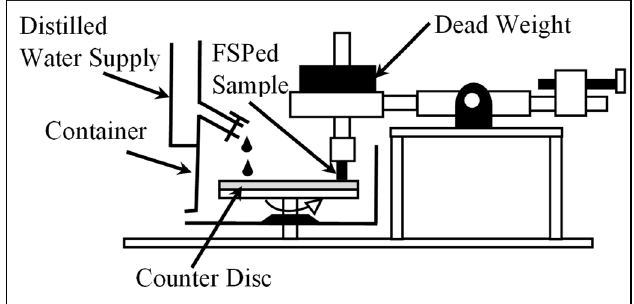
Figure 5. Pin-on-disc tribo-test schematic diagram [13].